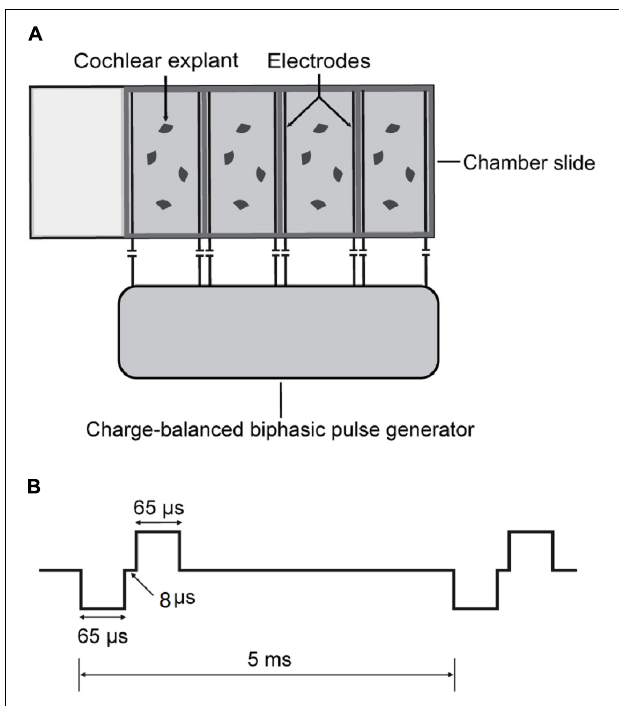
FIGURE 1 | Schematics of cochlear explant culture under charge-balanced biphasic ES. (A) Four-well chamber slides were used in cochlear explant culture. Two parallel platinum-iridium wires were introduced into each chamber against the floor through four holes at four corners. The wires were then connected with a charge-balanced biphasic pulse generator. (B) The charge-balanced biphasic pluses for ES had adjustable amplitudes, a 65- µ s pulse width, an 8- µ s open-circuit interphase gap, a 4862- µ s short-circuit phase, and a 200 Hz